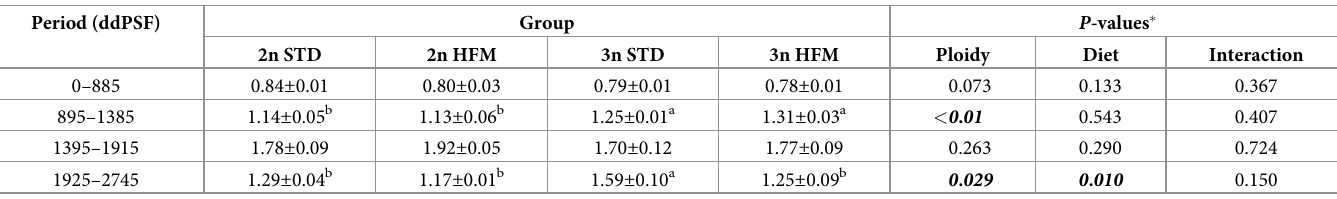
Table 2. Fish growth assessed using thermal growth